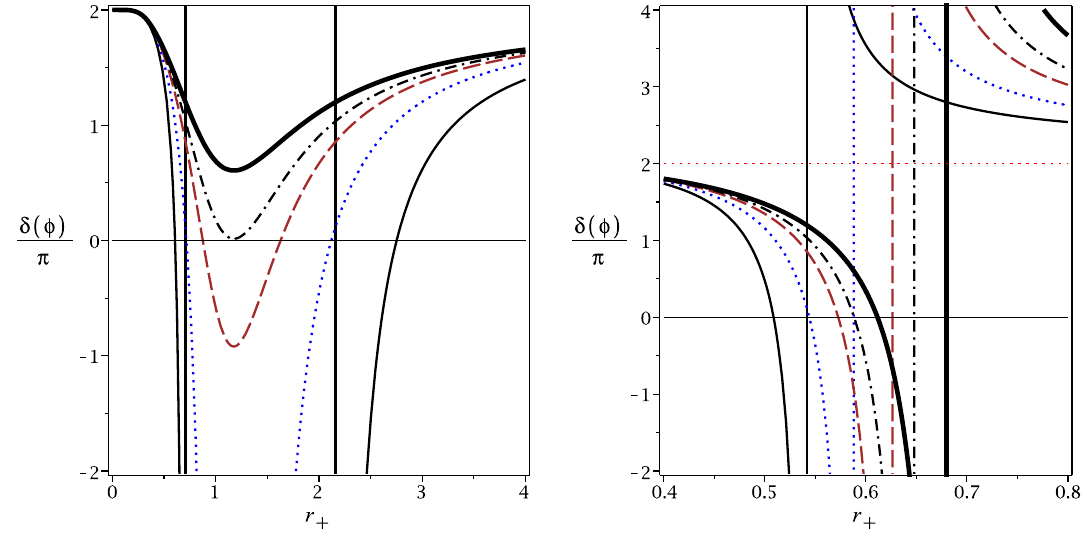
Fig. 3 PMI solutions: δ (φ) versus r + for q = 0 . 1, c = c 2 = c 3 = c 4 = m = l = 1, d = 5, s = 0 . 9, c 1 = − 10 (continuous line), c 1 = − 7 . 87 (dotted line), c 1 = − 6 . 5 (dashed line), c 1 = − 5 . 855 (dashed-dotted line) and c 1 = − 5 (bold line). Left diagram: (cid:3) = − 1; right diagram: (cid:3) =